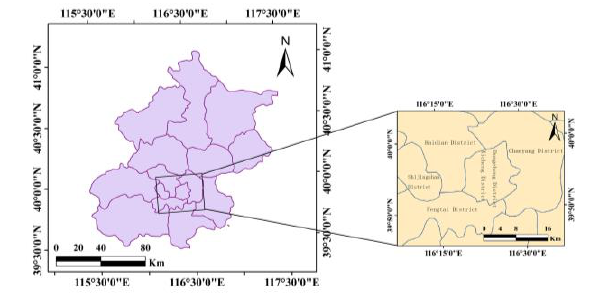
Figure 2. The results of three fusion methods. (a) Google Earth topographic map; (b) Gram-Schmidt spectral sharpening; (c) Principal Component Analysis transform; (d) Brovey transform.